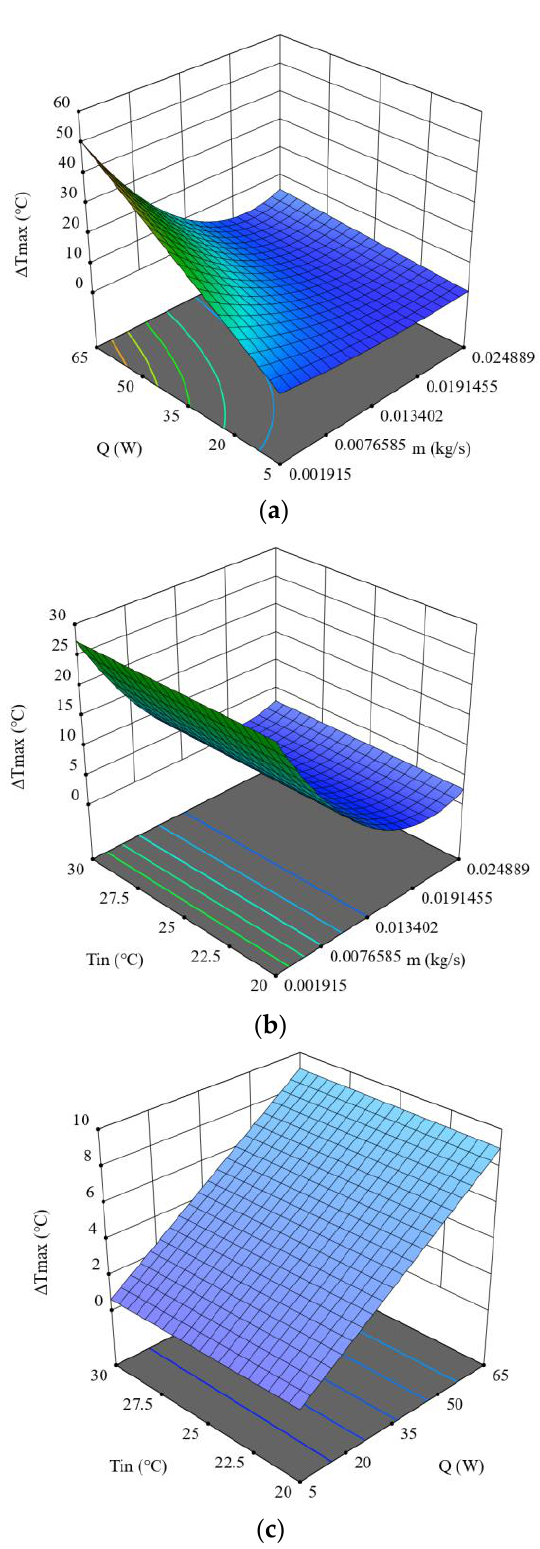
Figure 10. 3D surface plots of the combined effects on the average temperature: ( a ) Q · m ̇ ; ( b ) T in · m ̇ ; ( c ) Q · T in .